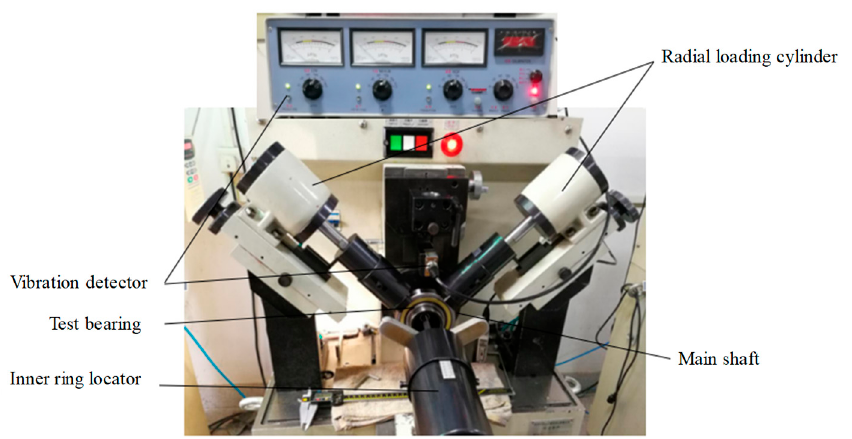
Figure 12. Overview of the test rig.